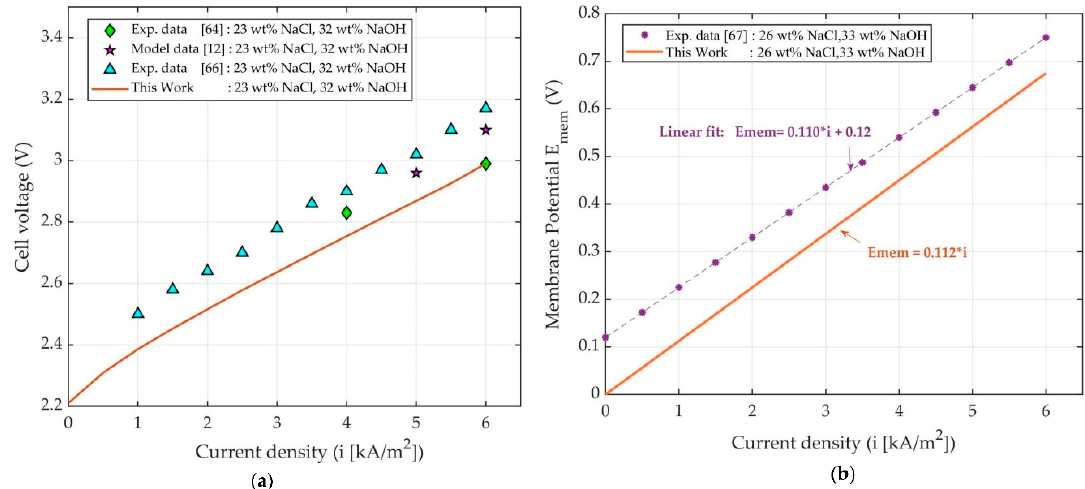
Figure 4. Comparison of the predicted data with experimental [64,66,67] and published model data [12] of total cell voltage E cell ( a ) and membrane potential E mem ( b ) as a function of current density ( i ) . The experimental data of Bergner et al. [67]: i = 6 kA m − 2 , NaCl = 26 wt%, NaOH = 33 wt%, temperature = 85 ◦ C and Nafion ® NX954 membrane. The experimental data of Takahashi et al. [64,66] and published model data of Baldea et al. [12]: i = 6 kA m − 2 , NaCl = 23 wt%, NaOH = 32 wt%, temperature = 90 ◦ C, and membranes: Aciplex F6801 [64], Aciplex F4401 [66].